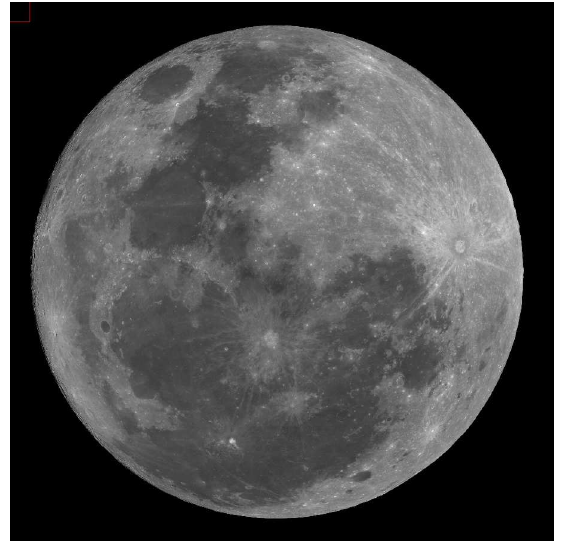
Figure 6 : PA image of the Moon used for absolute calibration